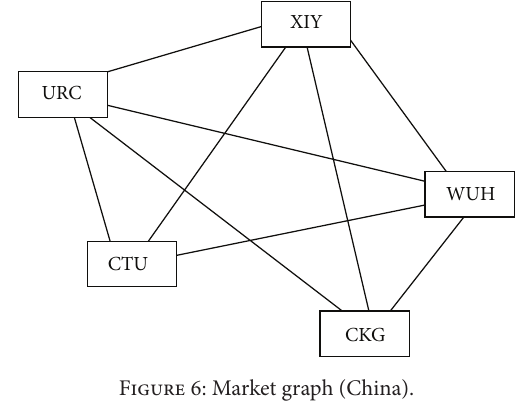
Figure 6: Market graph (China).